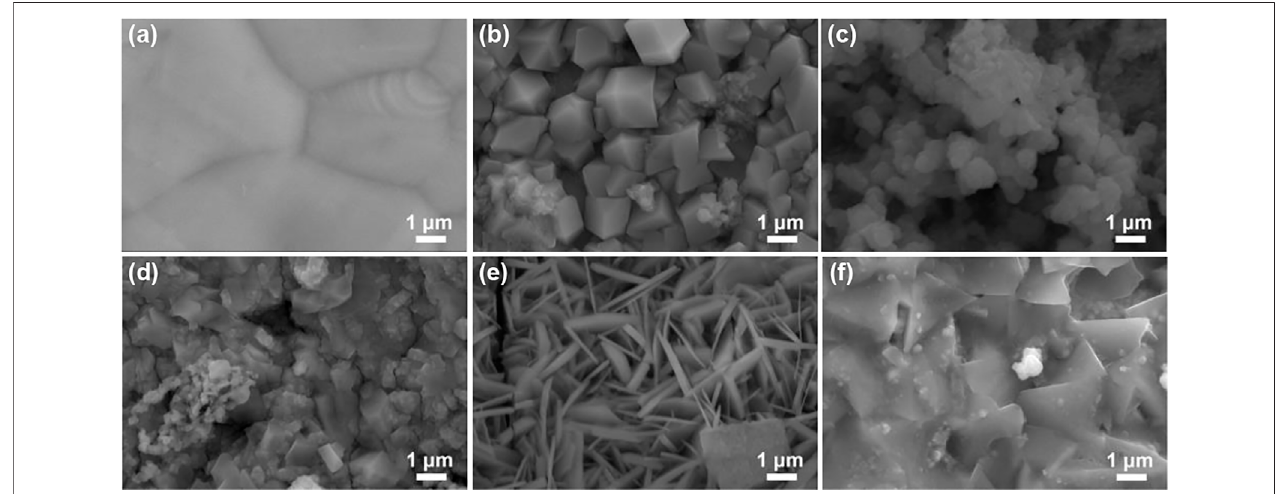
FIGURE 1 | SEM images of (A) Cu foam, (B) Mn – Cu, (C) Fe – Cu, (D) Co – Cu, (E) Ni – Cu, and (F) Pt –